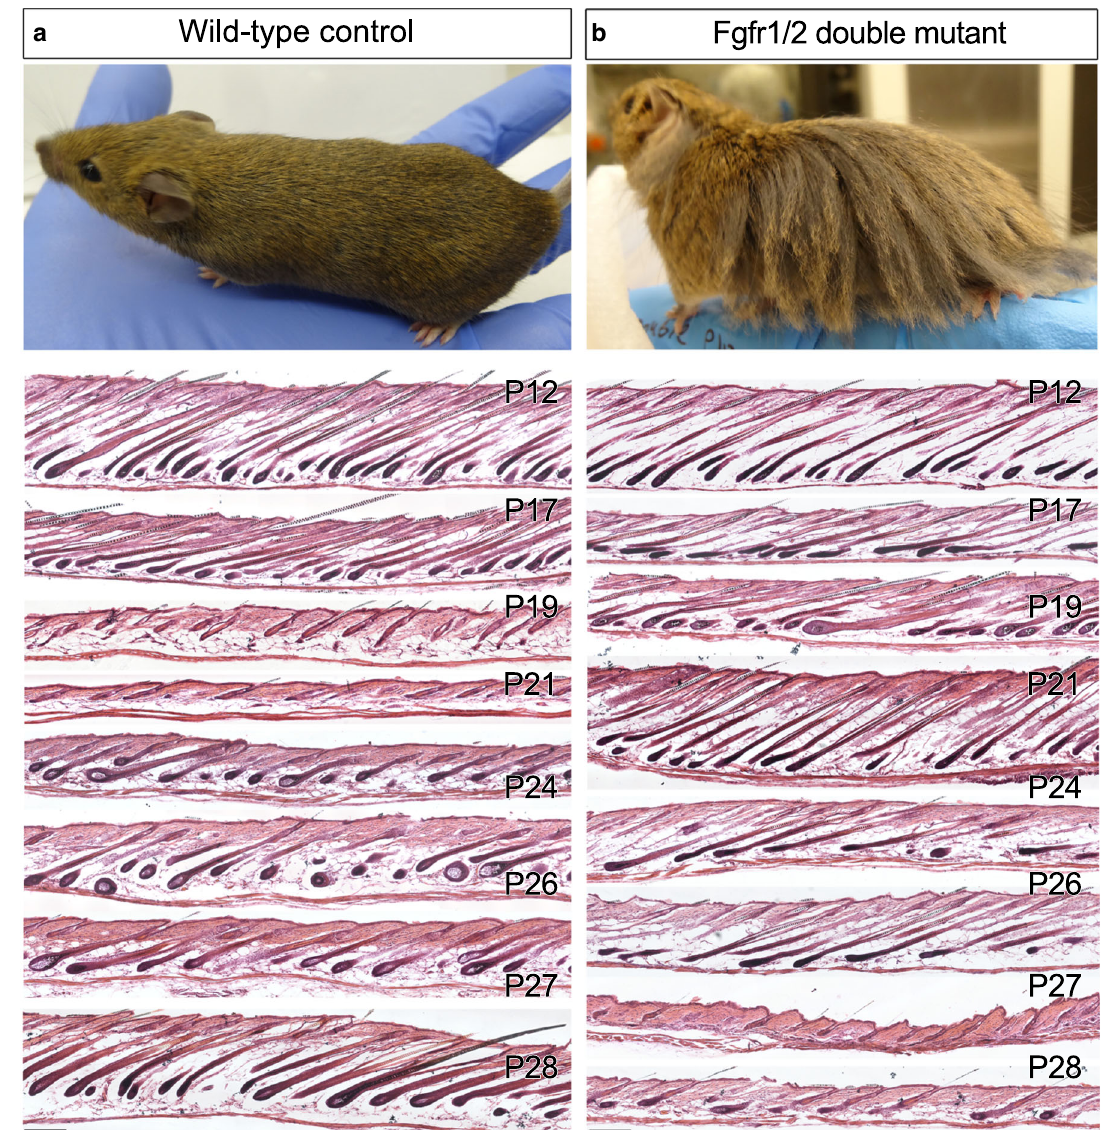
Fig. 2 Ablation of Fgf signaling in the DP results in extended anagen. In the upper panels, pictures of a wild type control ( a ) and a Fgfr1/2 double mutant ( b ), taken at postnatal day 50 (P50), are shown ( n > 10 mice per genotype). The panels below depict HE staining of dorsal skin sections derived from the posterior region of wild-type and mutant mice at different stages of the hair cycle (on the right side, P indicates postnatal day). Note the prolonged anagen in the double mutant. At P19, a wild-type skin section ( a ) is shown to illustrate mid-to-late catagen, while P24 and P26 are examples of Fgfr1/2 double mutant mice ( b ) that are in the transition from anagen to catagen. By contrast, wild-type follicles at P26 ( a ) have already completed regeneration and are in the mid anagen of the second cycle. n > 3 mice per genotype per stage. Scale bar, 200 μ